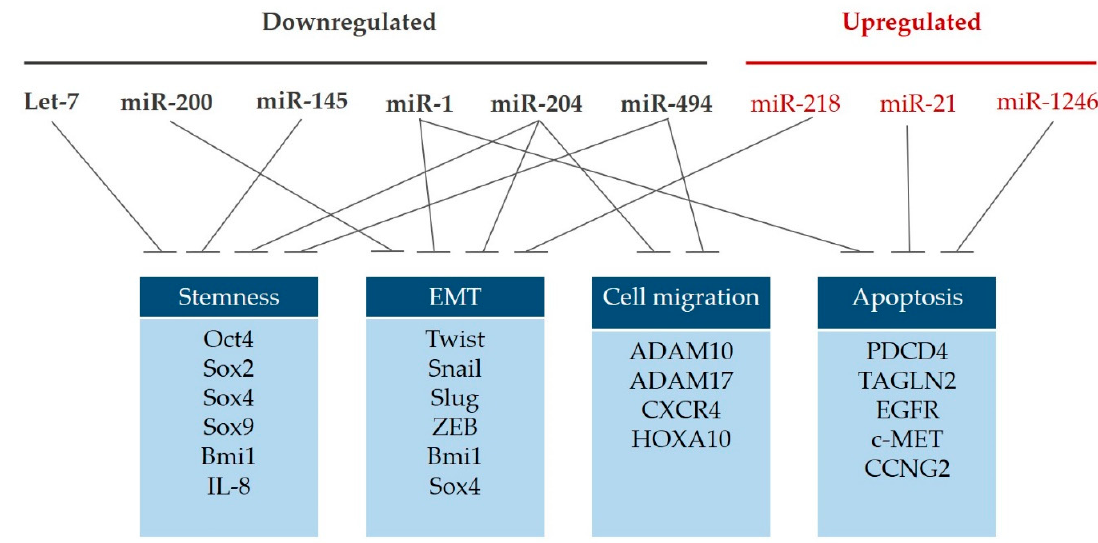
Figure 1. These aberrantly expressed miRs concertedly regulate key properties that affect cancer stemness in OSCC, especially cancer stemness and epithelial–mesenchymal transition (EMT). Author Contributions: Conceptualization, C.-C.Y.; writing—original draft preparation, P.-L.H.; writing—review and editing, P.-L.H., Y.-W.L. and M.P. All authors have read and agreed to the published version of the manuscript.